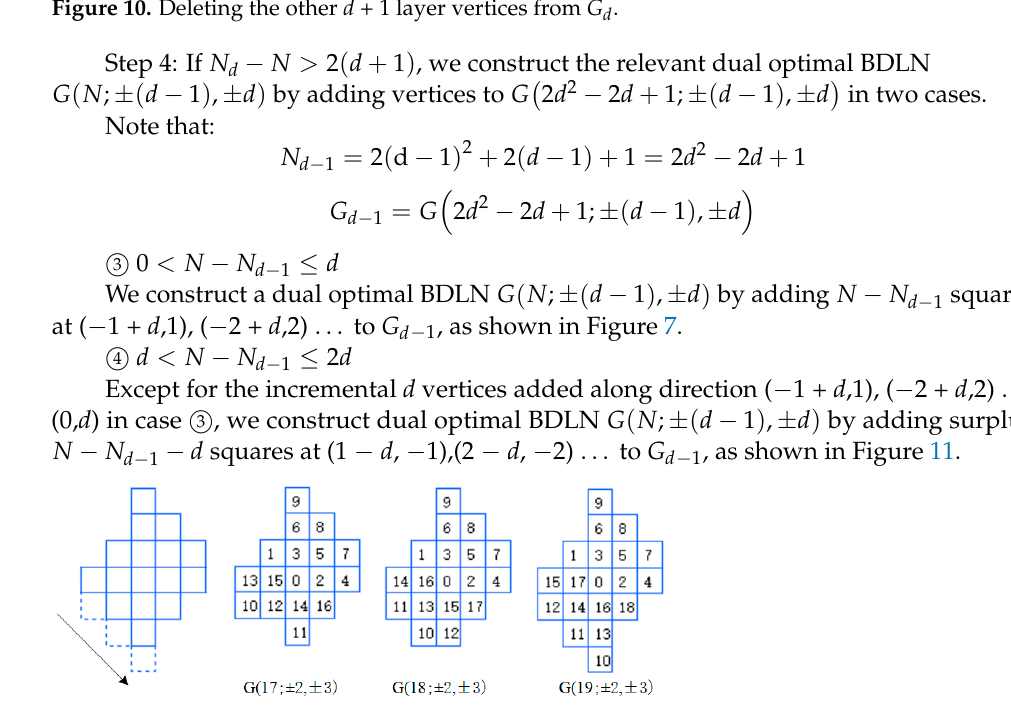
Figure 11. Adding the other d + 1 layer vertices to G d − 1 .